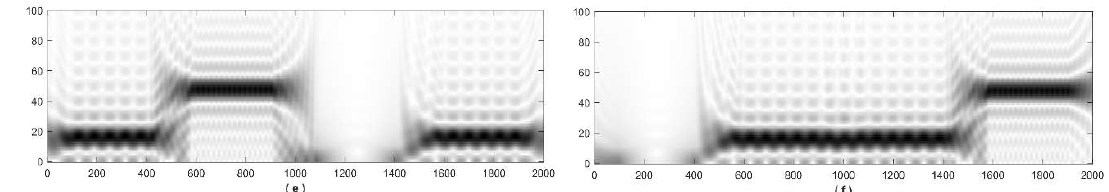
Figure 2. Time-frequency Distribution of Non-stationary Signals: ( a , b ) Two signals with frequency components that vary with time; ( c , e ) Welch power spectrum density estimation and time frequency distribution of the signal in ( a ); ( d , f ) Welch power spectrum density estimation and time frequency distribution of the signal in ( b ).